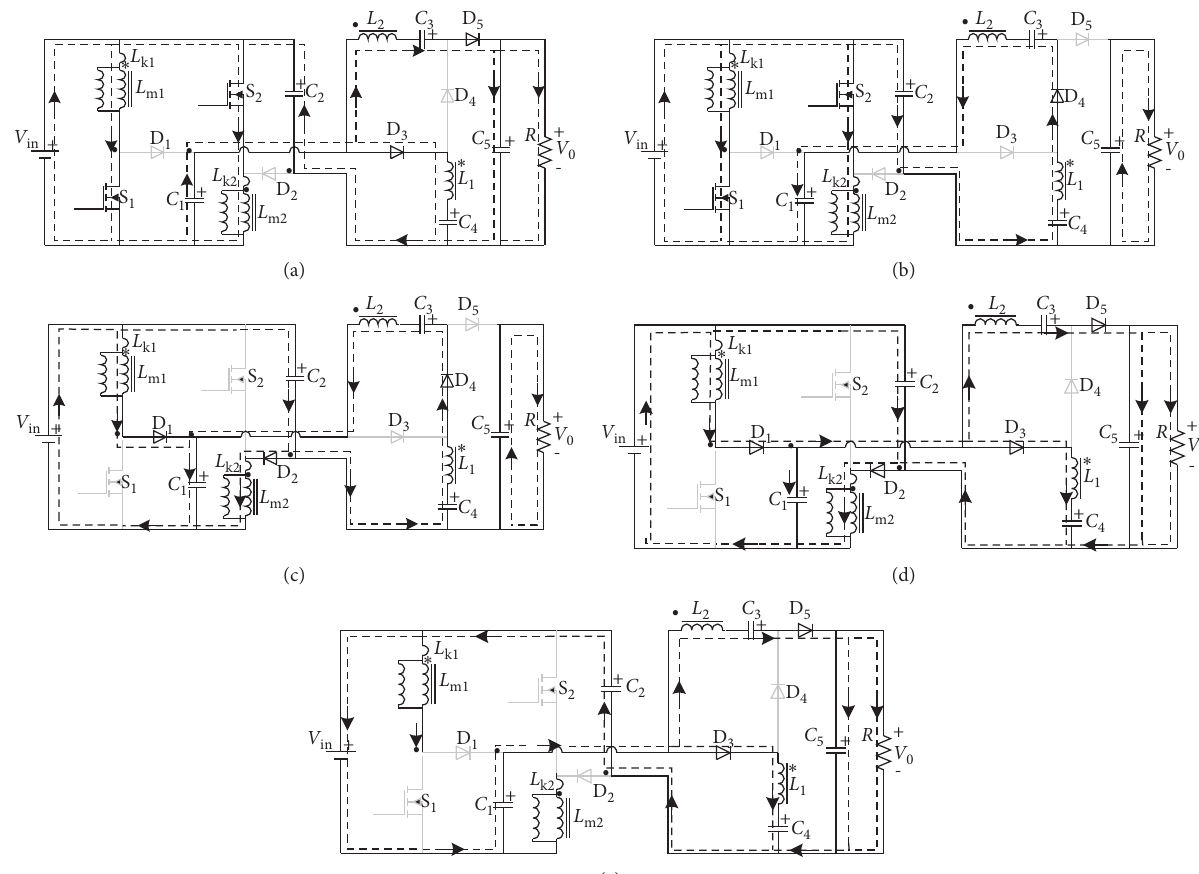
Figure 5: Equivalent circuit of each operating mode of the converter. (a) Operating mode I. (b) Operating mode II [ t